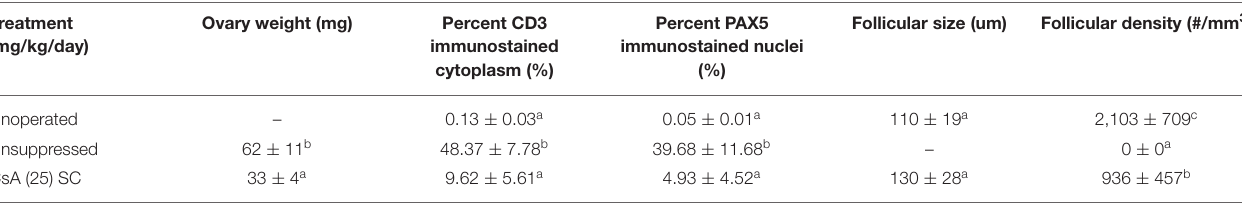
TABLE 7 | Ovary weight and lymphocytic levels, along with follicle size and density from Study 3. Treatment